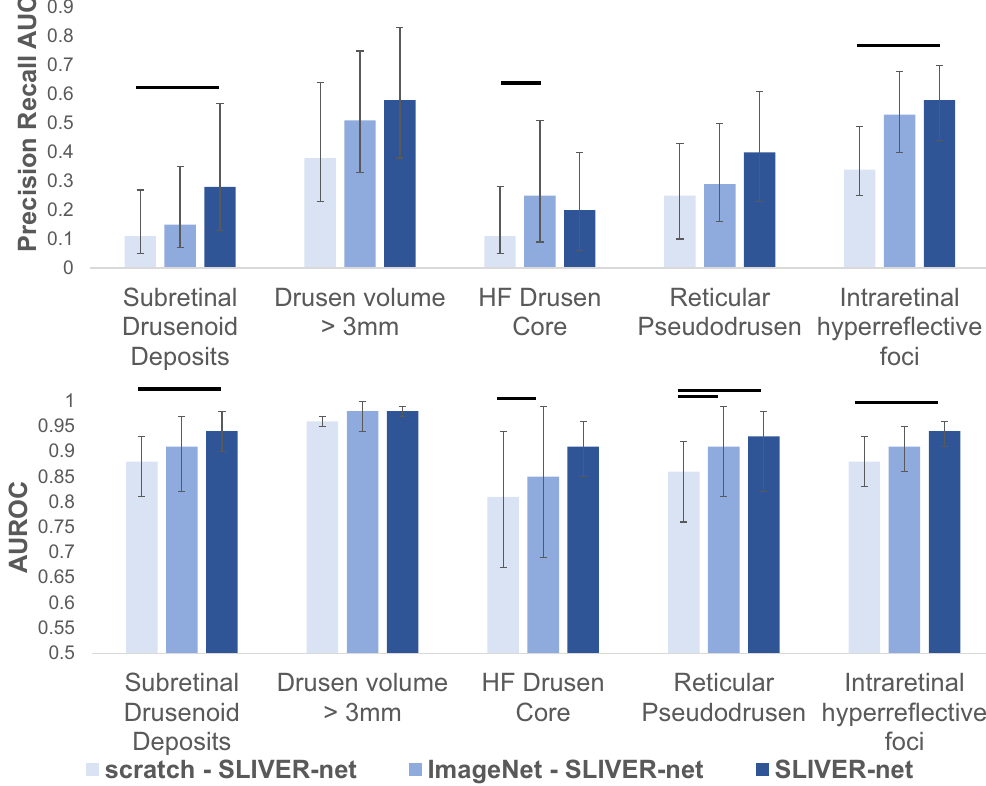
Fig. 7 Transfer learning evaluation. Comparison of external datasets and their effect on performance. SLIVER-net trained from scratch (light blue), pre-trained using ImageNet (blue), and pre-trained using Kermany (dark blue). Top: Precision-recall AUC for each biomarker. Bottom: ROC AUC for each biomarker. Horizontal bars indicate statistically signi fi cant differences ( p < 0.05). Error bars represent 95% con fi dence interval (CI) calculated using a bootstrapping